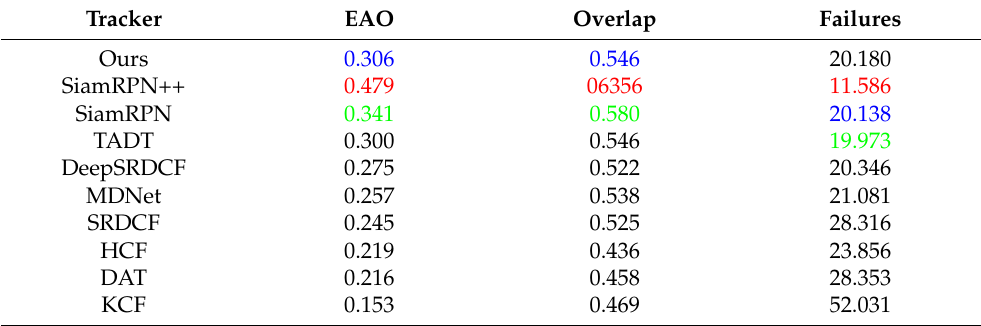
Figure 13. EAO score ranking of the compared trackers VOT2016 dataset. Table 2. Overall performance on VOT2016 dataset, the top three trackers are marked with red, green and blue,